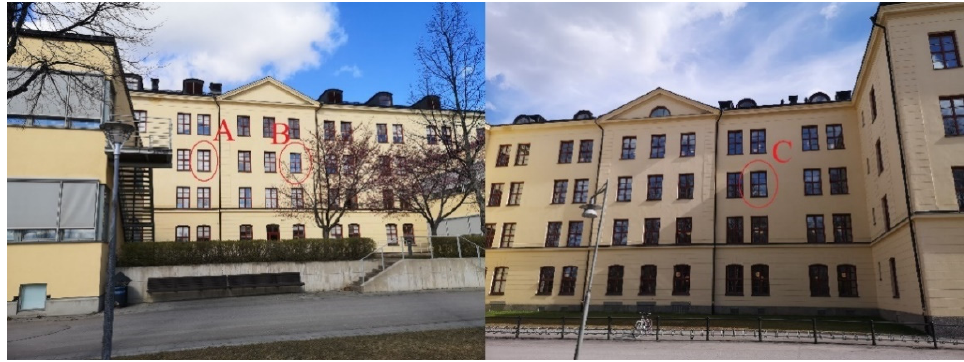
Figure 1. The windows to Rooms A and B face south, and the window to Room C faces north.